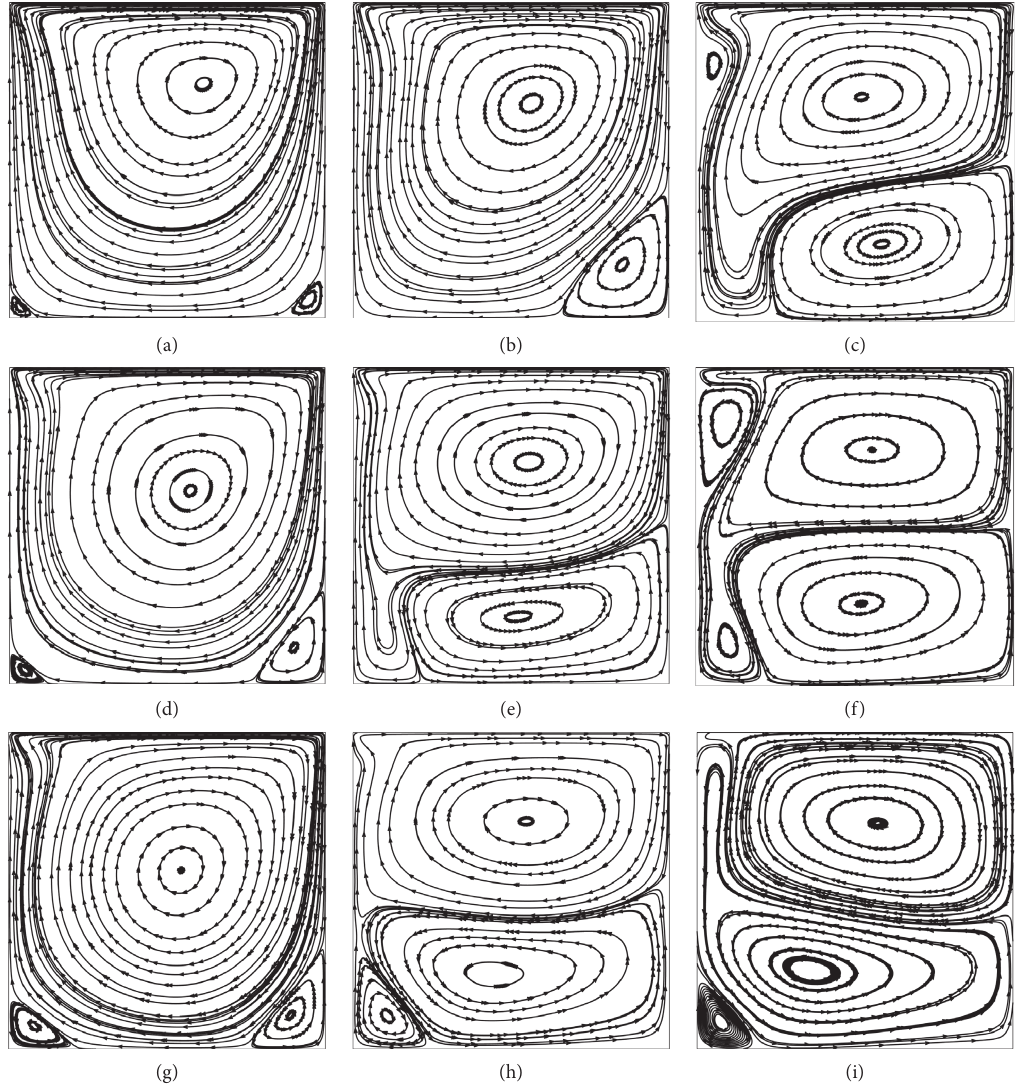
Figure 2: Simulated streamlines for different Re and Ri values. ( Re , Ri ) � (a) (100, 0.001), (b) (100, 1), (c) (100, 10), (d) (400, 0.001), (e) (400, 1), (f) (400, 10), (g) (1000, 0.001), (h) (1000, 1), and (i) (1000,